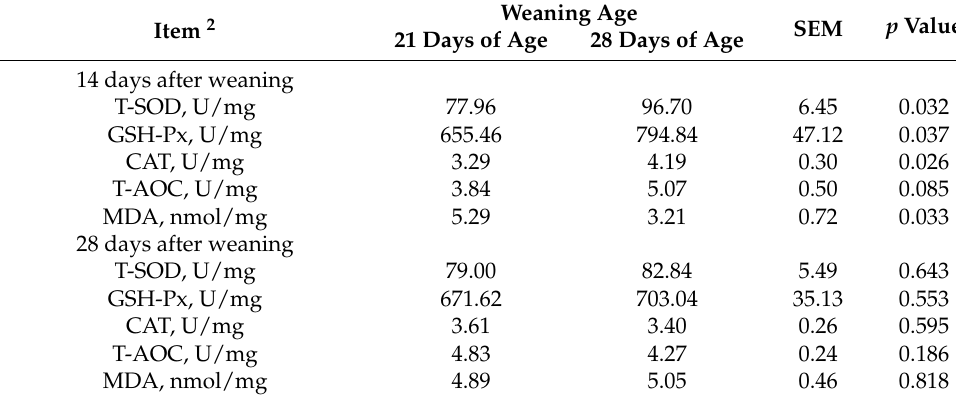
Table 10. Effect of weaning age on kidney antioxidant indexes of weaned pigs 1 .